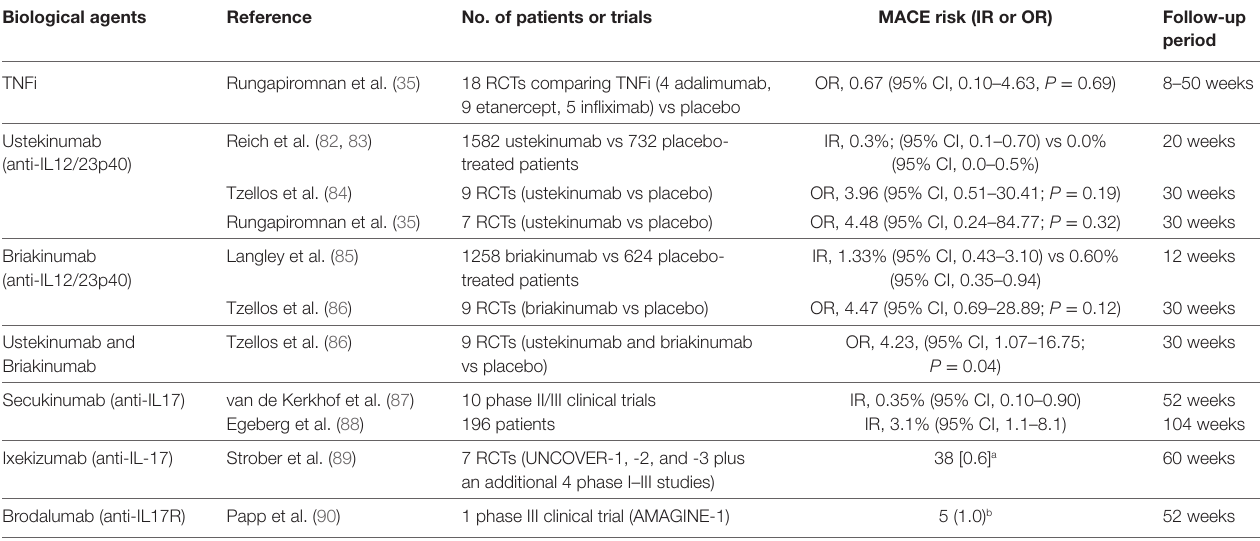
TABLe 1 | Main randomized controlled trials and meta-analysis studies on the rates of major adverse cardiovascular events (MACEs) in psoriatic patients treated with biological agents. Biological